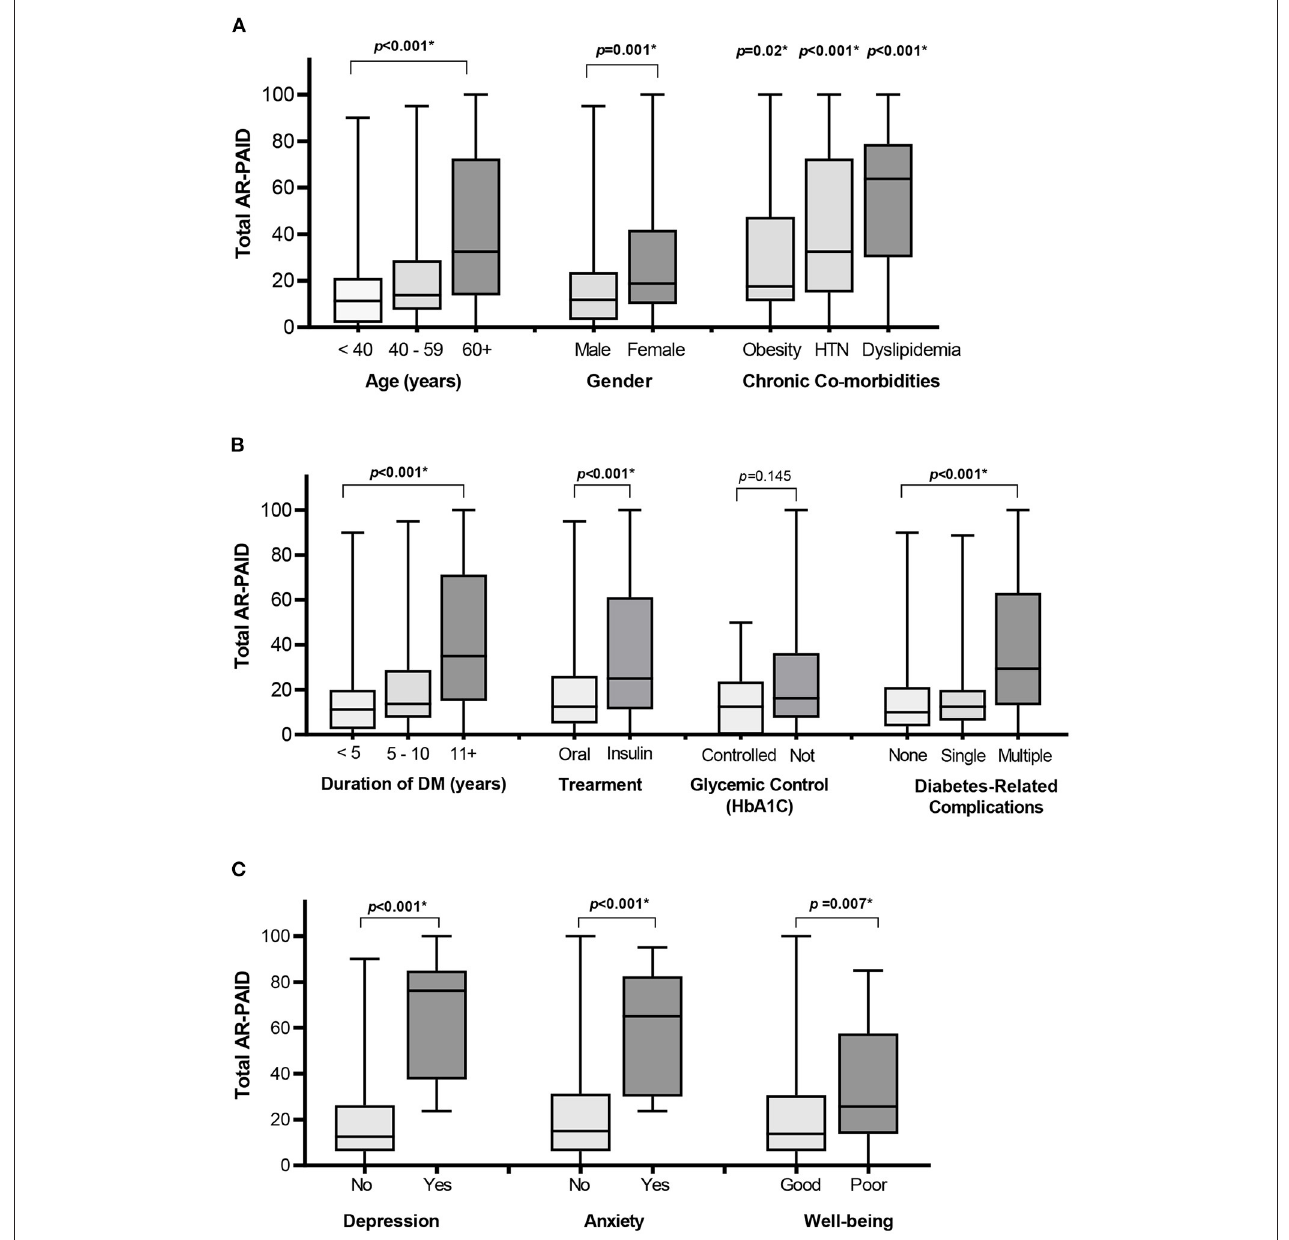
FIGURE 1 | Distribution of total AR-PAID score by patients’ demographic and clinical characteristics: age, gender, and co-morbidities (A) , diabetes-related characteristics (B) , and depression, anxiety, and WHO-wellbeing scales (C) . *Indicates a statistically significant p < 0.05. DM, diabetes mellitus; HTN, hypertension; WHO-5, 5-item World Health Organization Well-Being